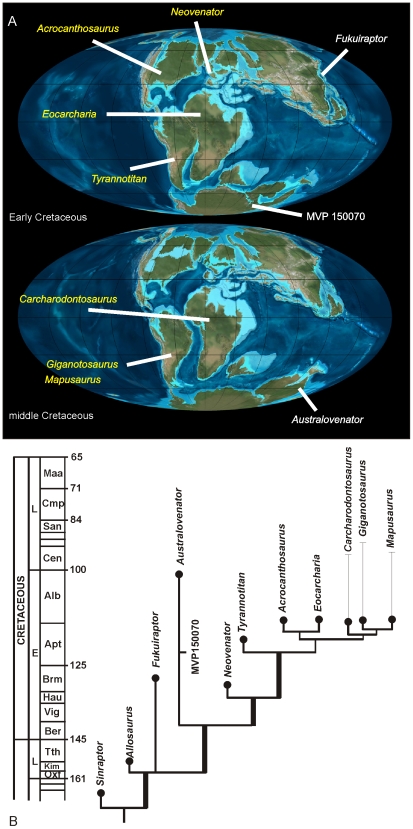
Palaeobiogeographic map and strato-phylogeny of Australovenator wintonensis.
A. Palaeogeographic globe for the Early and middle Cretaceous [51]. White-lettered taxa represent allosauroids basal to the Carcharodontosauridae. Yellow-lettered taxa represent members of the Carcharodontosauridae. B. Stratigraphically calibrated phylogeny based on the phylogeny of the current analysis and adapted from [18].